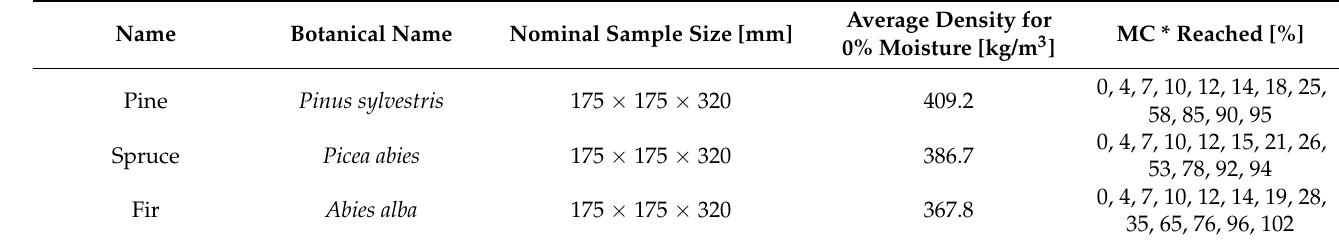
* The table lists approximate values. The moisture content (MC) values were used in the analysis with an accuracy of 1/100%.